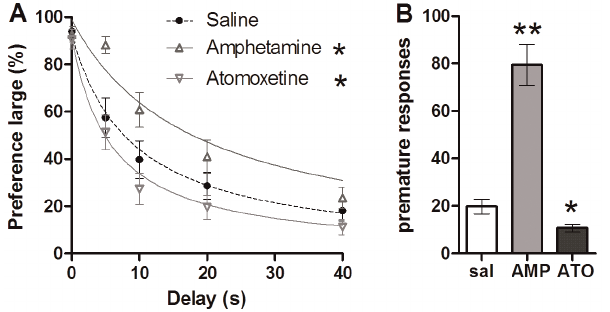
Figure 2. Pharmacological manipulation of impulsive choice and action in rats. In rats (n=22), the preference for the large